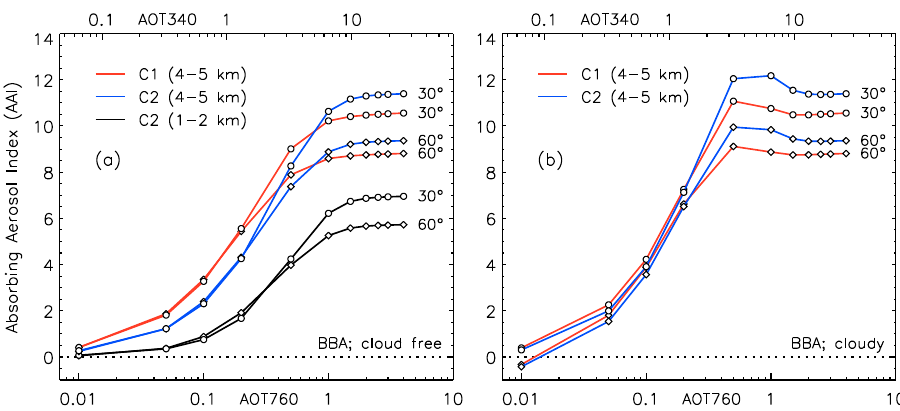
Fig. 4. Simulations of the absorbing aerosol index for biomass burning aerosols as a function of aerosol optical thickness in (a) cloud free scene and (b) cloudy scene. The scenes are the same as in Figs. 1–3. Results for two solar zenith angles are plotted, 60 ◦ and 30 ◦ . Viewing direction is nadir. The x-axis AOT340 is for BBA Case 2 (C2), which is very similar to AOT340 for BBA Case 1